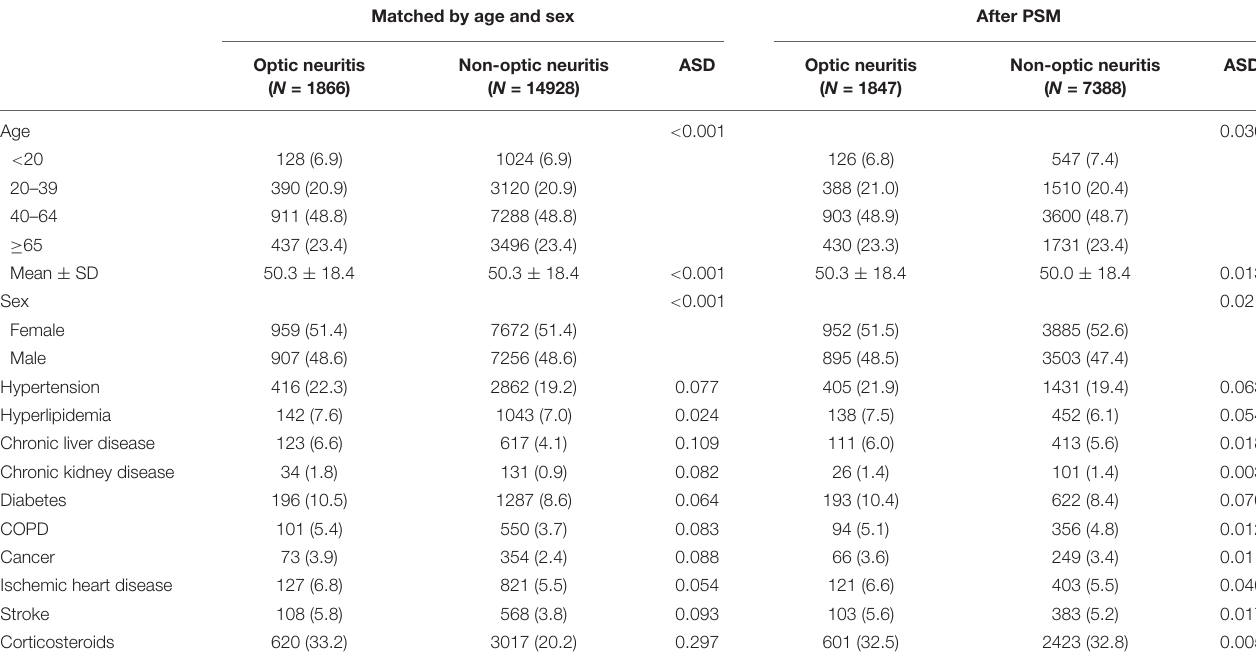
TABLE 1 | Demographic characteristics of optic neuritis group and non-optic neuritis group. Matched by age and